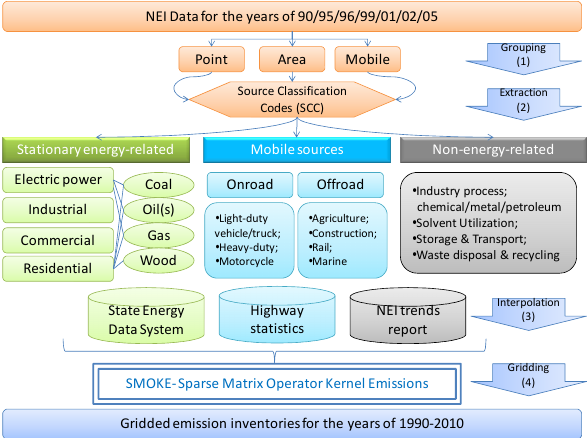
Fig. 1 The framework of the 20 years emission inventory development Fig. 1. The framework of the 20yr emission inventory